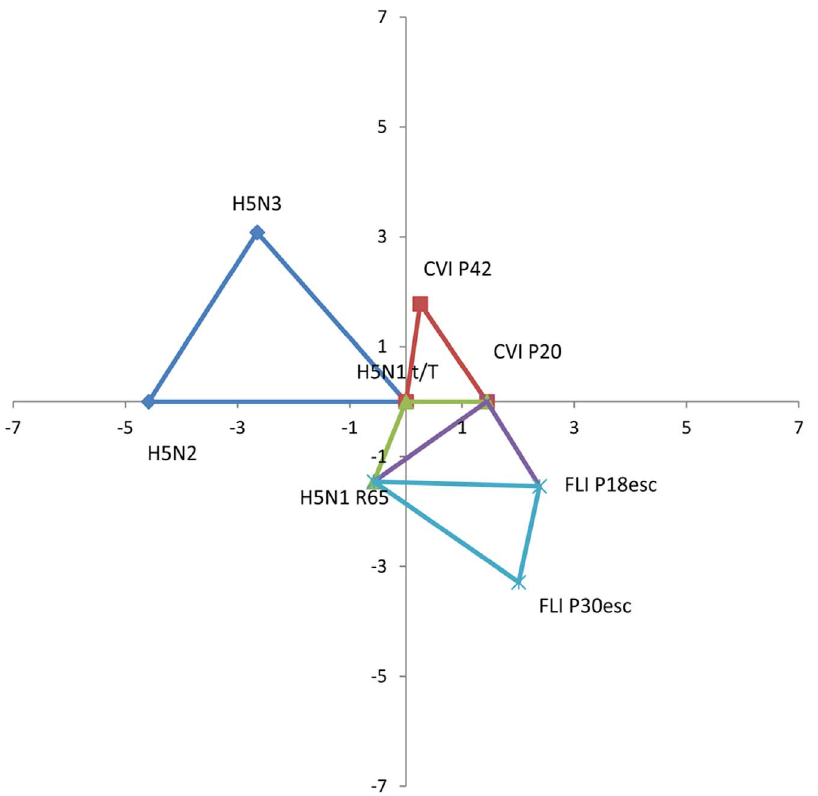
Figure 3. Antigenic map of sets of sera raised against the strains used in this study. Antigenic map showing the standardized real distances between different sets of three sera. Distances are in log 2 values. Antigenic distance between sera from H5N1 t/T and CVI P20 or CVI P42 is 1.44 and 1.8 respectively. Distance between sera from H5N1 R65 and FLI P18esc or FLI P30esc is 2.95 and 3.16 respectively. Sera raised against the parent strains (H5N1 t/T and H5N1 R65) have a distance of 1.56. Sera raised against H5N1 t/T and H5N1 R65 are very antigenically distant to sera raised against the H5N2 and H5N3 strains used in the study. In detail, the distance between sera raised against H5N1 t/T and H5N2 or H5N3 is 4.58 and 4.07 respectively, while the distance between sera raised against H5N1 R65 and H5N2 or H5N3 is 3.71 and 4.14 respectively (all distances can be found in Table S3 in File S1).